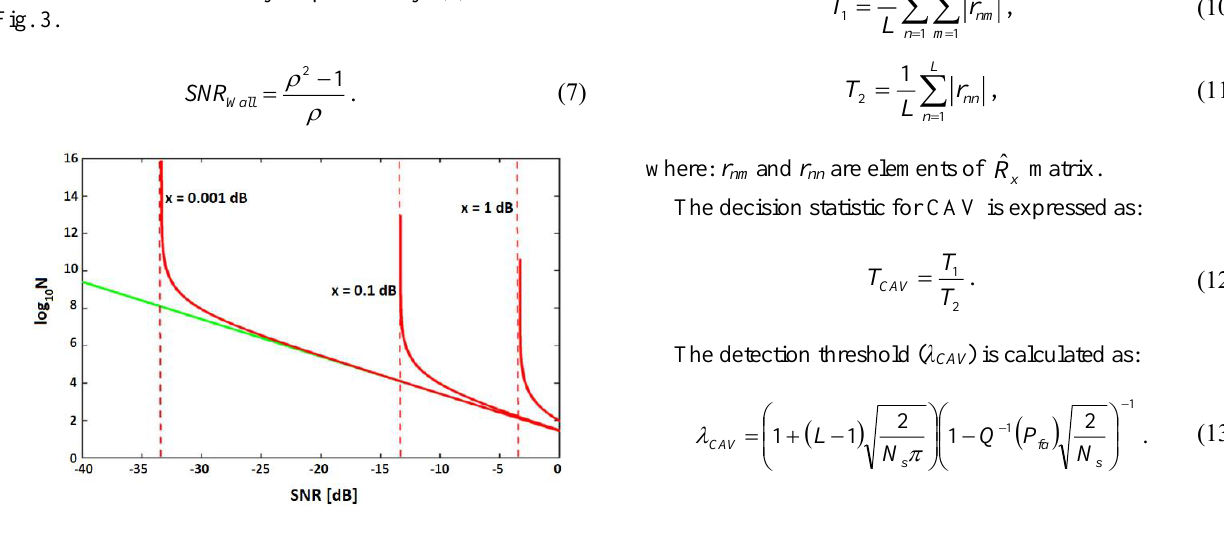
Figure 2. Number of samples in SNR function depending on the spectral density of noise power